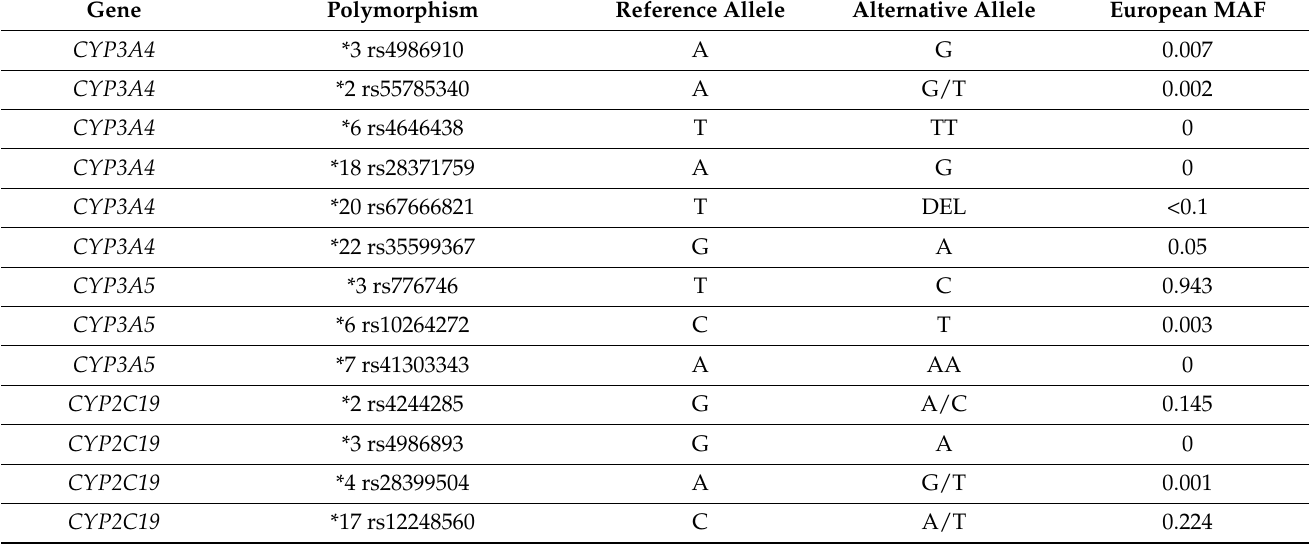
Table 1. Summary of polymorphisms in CYP and ABCB1 genes potentially involved in BTZ pharma- cokinetics and their frequency in the European